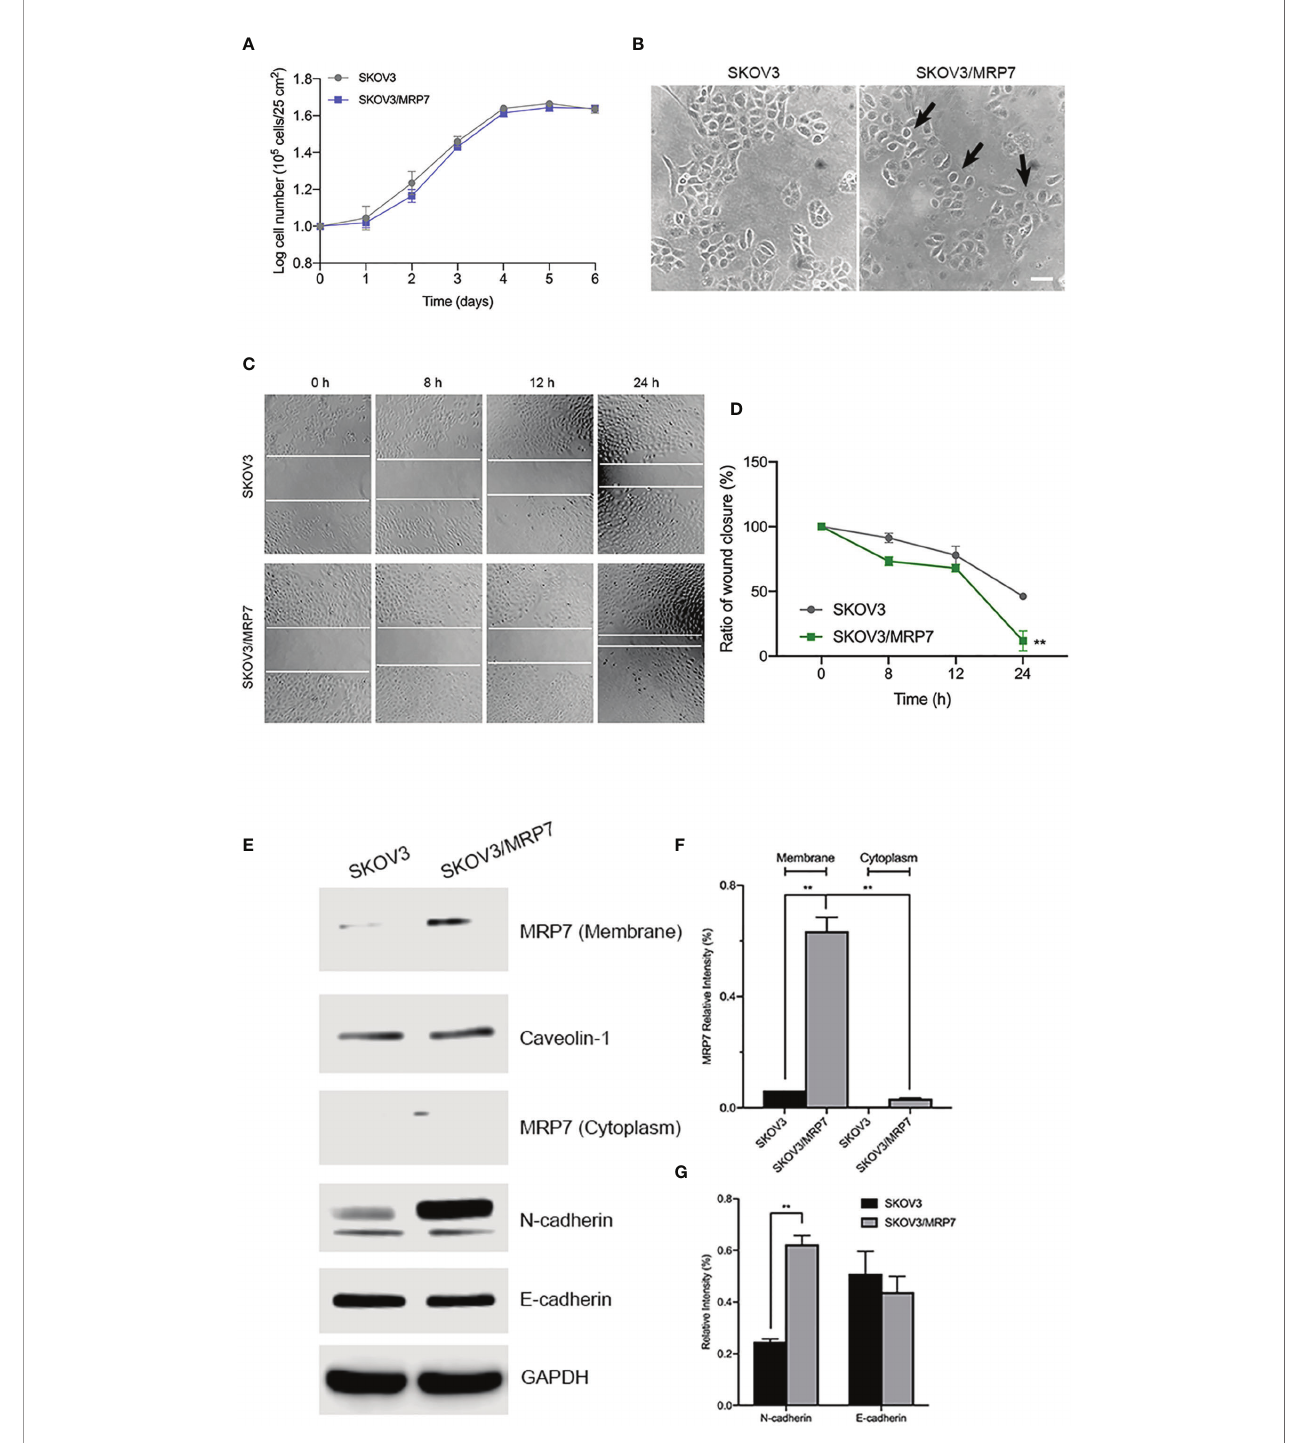
FIGURE 2 | Morphology, migration and EMT marker expression of SKOV3 and SKOV3/MRP7 cells. (A) Growth curve of SKOV3 and SKOV3/MRP7 cells. (B) Cell morphology of SKOV3 and SKOV3/MRP7 cells under optical microscope. Scale bar = 100 m m. Black arrows indicating reduced cell-cell contact. (C) Wound healing assay of SKOV3 and SKOV3/MRP7 cells. White solid line indicates the edges. (D) Semi-quanti fi cation of wound healing assay. Grey and green solid line represent the ratio of wound closure of SKOV3 and SKOV3/MRP7 cells, respectively. (E) Western blotting of membrane/cytoplasm protein and EMT markers. (F) Semi- quanti fi cation of membrane/cytoplasm protein. (G) Semi-quanti fi cation of EMT marker expression. **p < 0.01 versus the negative control group. Data are expressed as mean ± SD derived from three independent